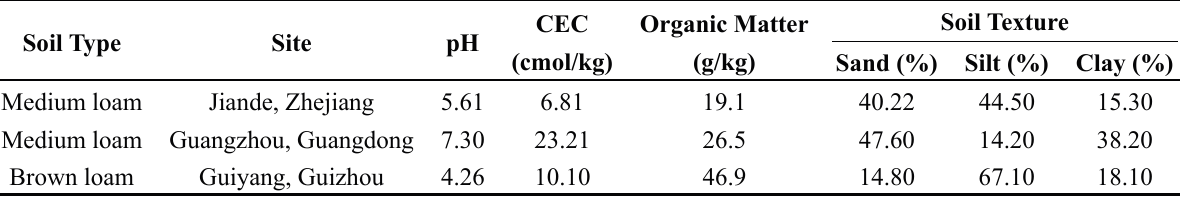
Table 5. Characteristics of orchard soils that were sprayed with glyphosate soluble